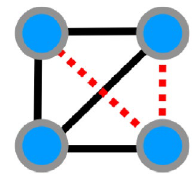
Figure 1. Examples of the two types of star growth operations considered within this